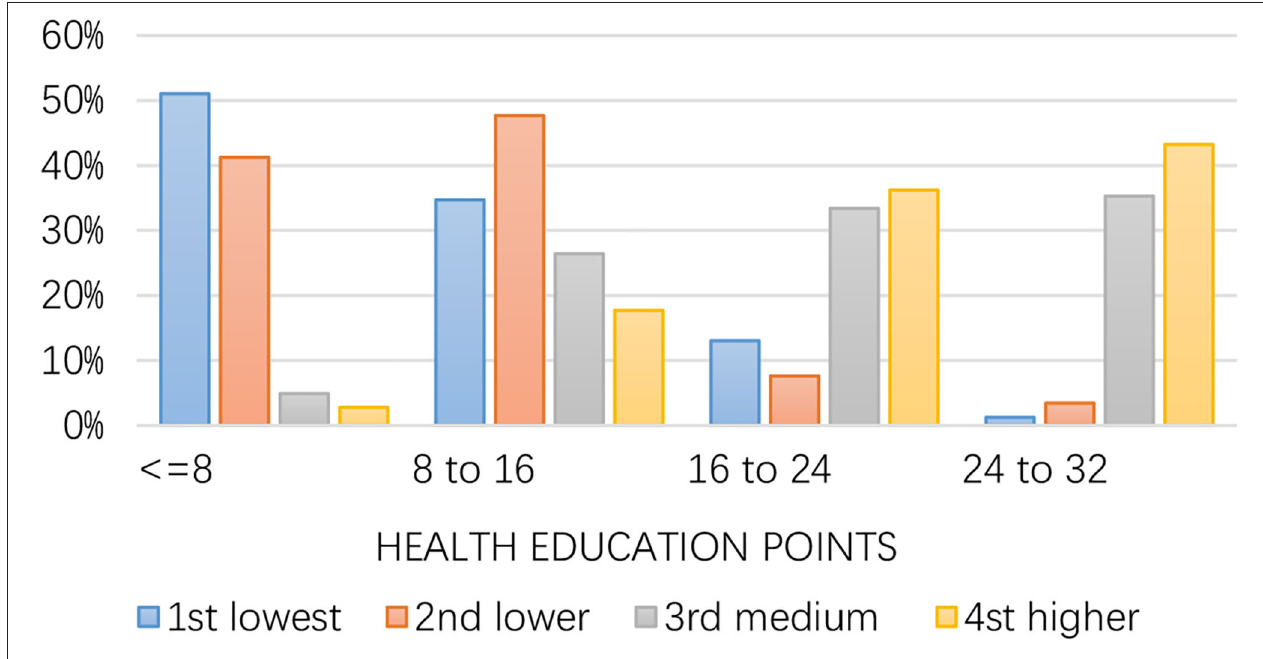
FIGURE 2 | Health education, by consumption groups.